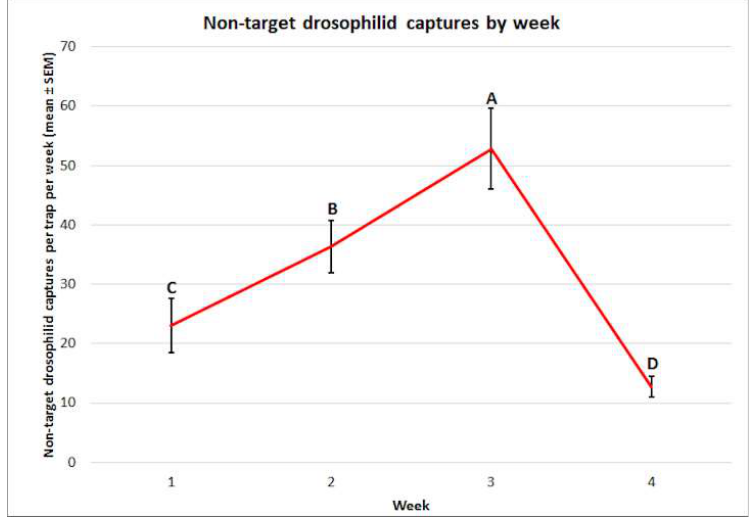
Figure 11. Mean (± SEM) non-target drosophilid captures by week. Different letters represent